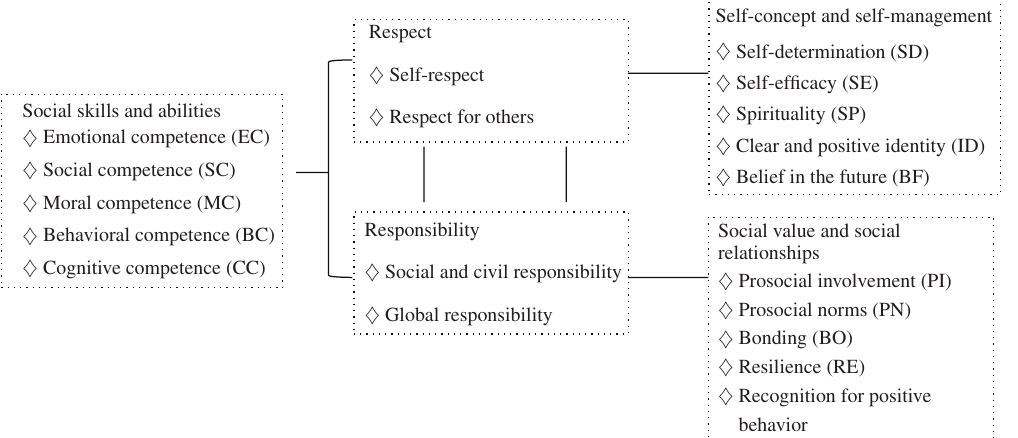
FIGURE 1: The relation of positive youth development constructs to respect and